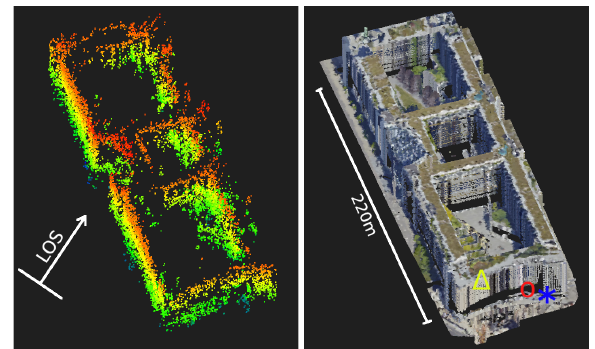
Figure 5. Left: 13000 PS Points on the building (Z-color-coded, segmented from OSM footprint). Right: ALS point cloud of the building. The levelling points are marked by ◦ and ∗ , the position of the 3D tachymeter prism is marked by ∆ . The corresponding time series are shown in Figure 9 and 11.